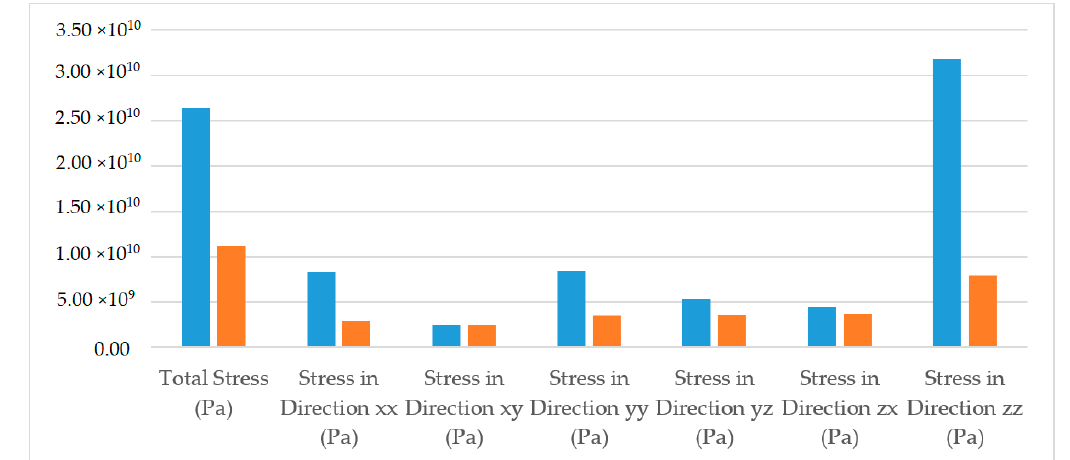
Figure 10. Comparison of overall and partial stress of the original model and the alternative solution with topology with star-shaped elements . Table 2. Stress acting in the individual directions in the case of the proposed alternative